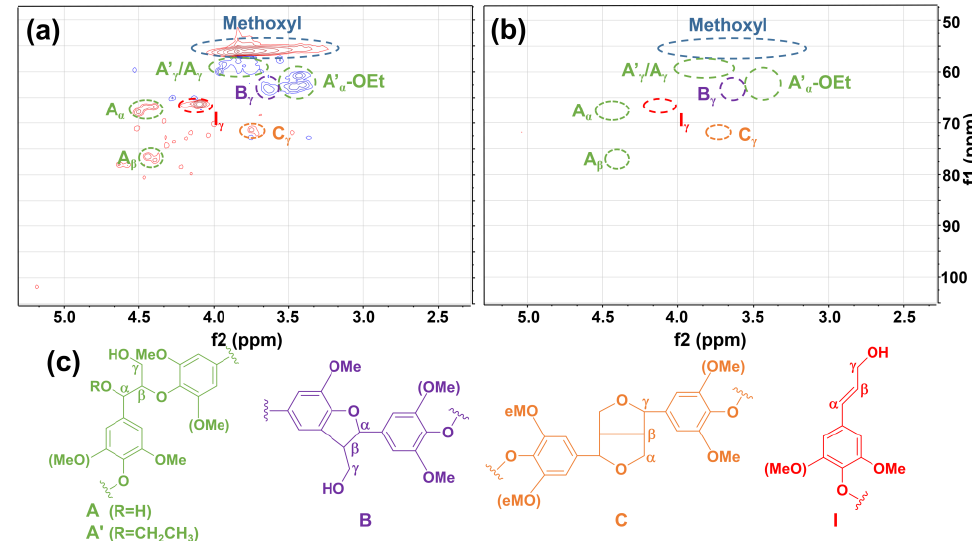
Figure 11. 2D-HSQC-NMR spectroscopy of C – O linkages for ( a ) fresh dealkaline lignin and ( b ) the residue; ( c ) representative structures for ether linkages.